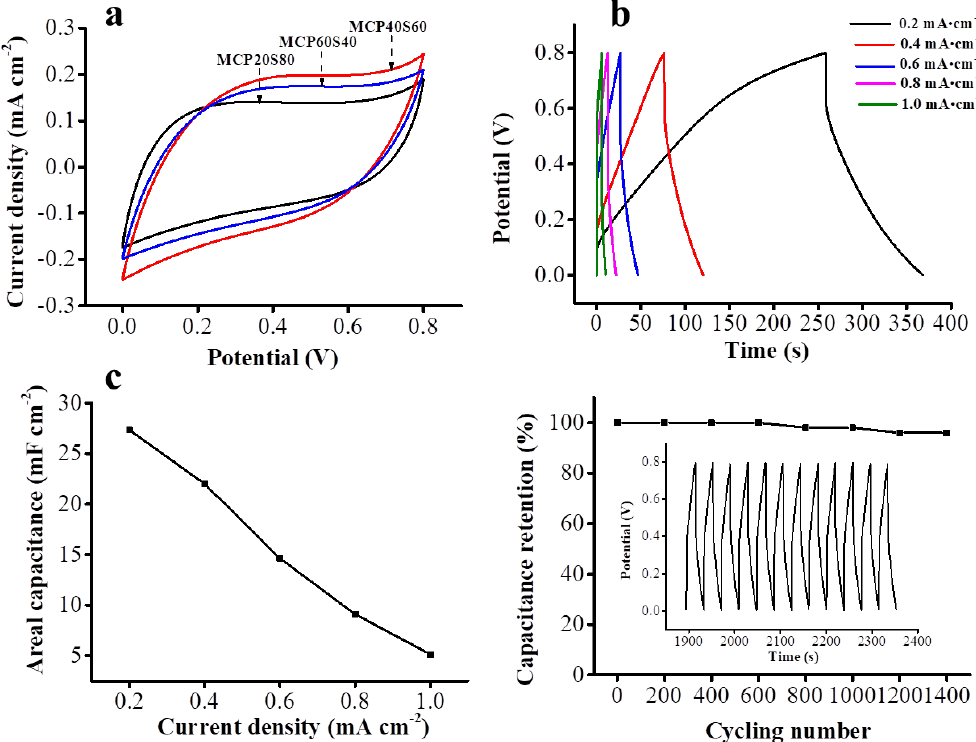
Figure 3. ( a ) CV curves of the supercapacitors with different PCL contents at 5 mV s − 1 ; ( b ) galvanostatic charge/discharge curves of MCP40S60 supercapacitors collected at different current densities; ( c ) areal capacitances of MCP40S60 supercapacitors at different current densities; ( d ) cycle stability of MCP40S60 electrode film at 0.6 mA cm − 2 .